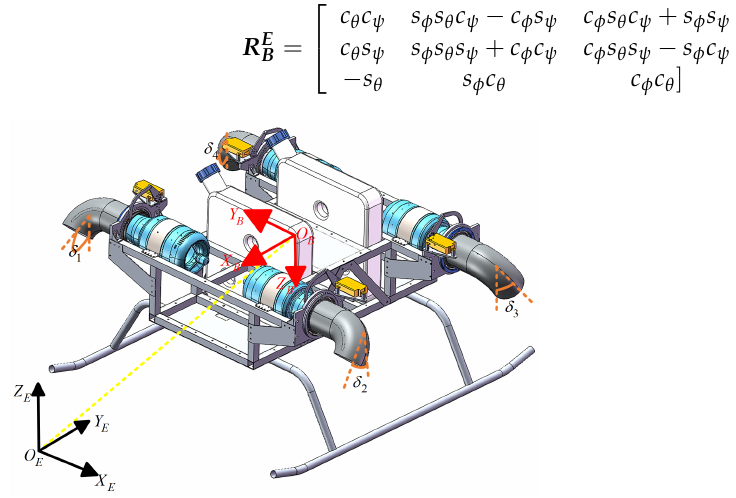
Figure 9. The inertial and body coordinate